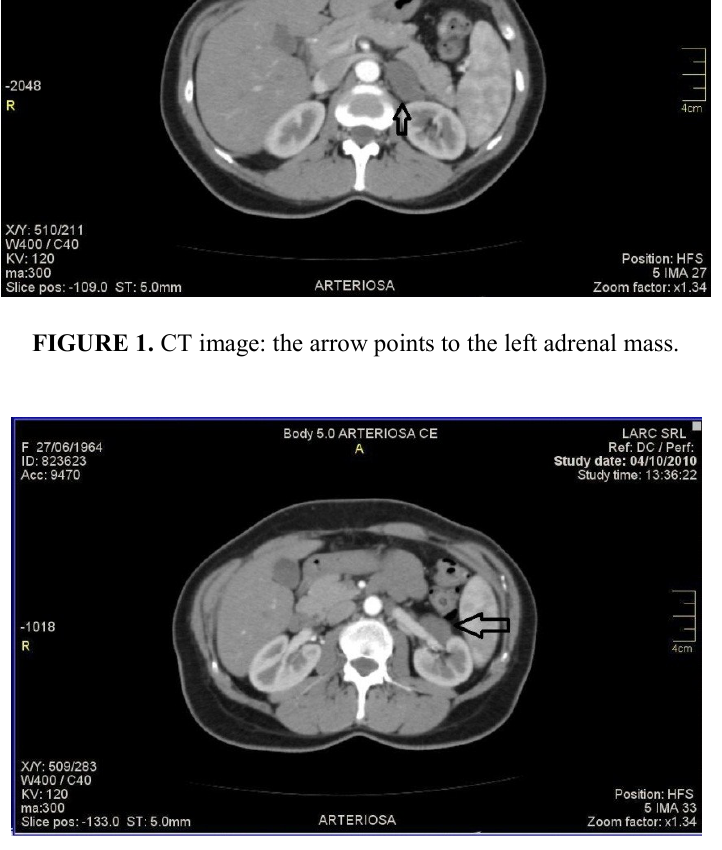
FIGURE 2. CT image: the arrow points to a mass next to the renal artery. Intraoperatively, this mass was detached from the previous one, demonstrating the multifocality of the